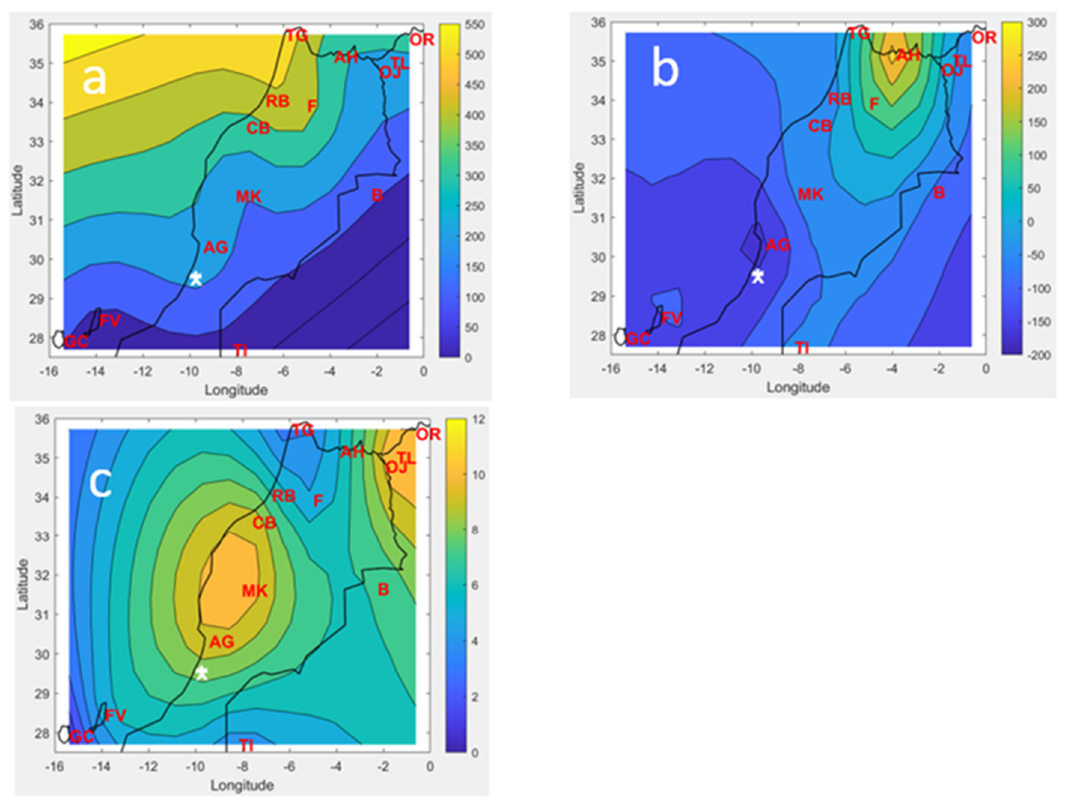
Figure 4. ( a ) Mean yearly rainfall (mm · yr − 1 ) during the period 2005–2020. ( b ) Yearly rainfall difference (mm · yr − 1 ) between both years 2020 and 2005. ( c ) Ratio r (%) between the means of the yearly cumulative dew and rainfall volumes over the period 2005–2020 (Equation (15)). Red letters: Measurement sites (see Table 1). Right and inclined crosses (very close) represent, respectively, Mirleft (43 m asl, 200 m from the coast) and Id Ouasskssou (240 m asl, 8 km from the coast), both sites studied in [17].